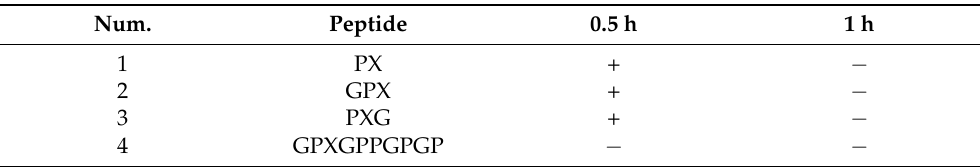
Table 4. Identification of oligopeptides (dipeptides and tripeptides) in rat plasma after oral adminis- tration of